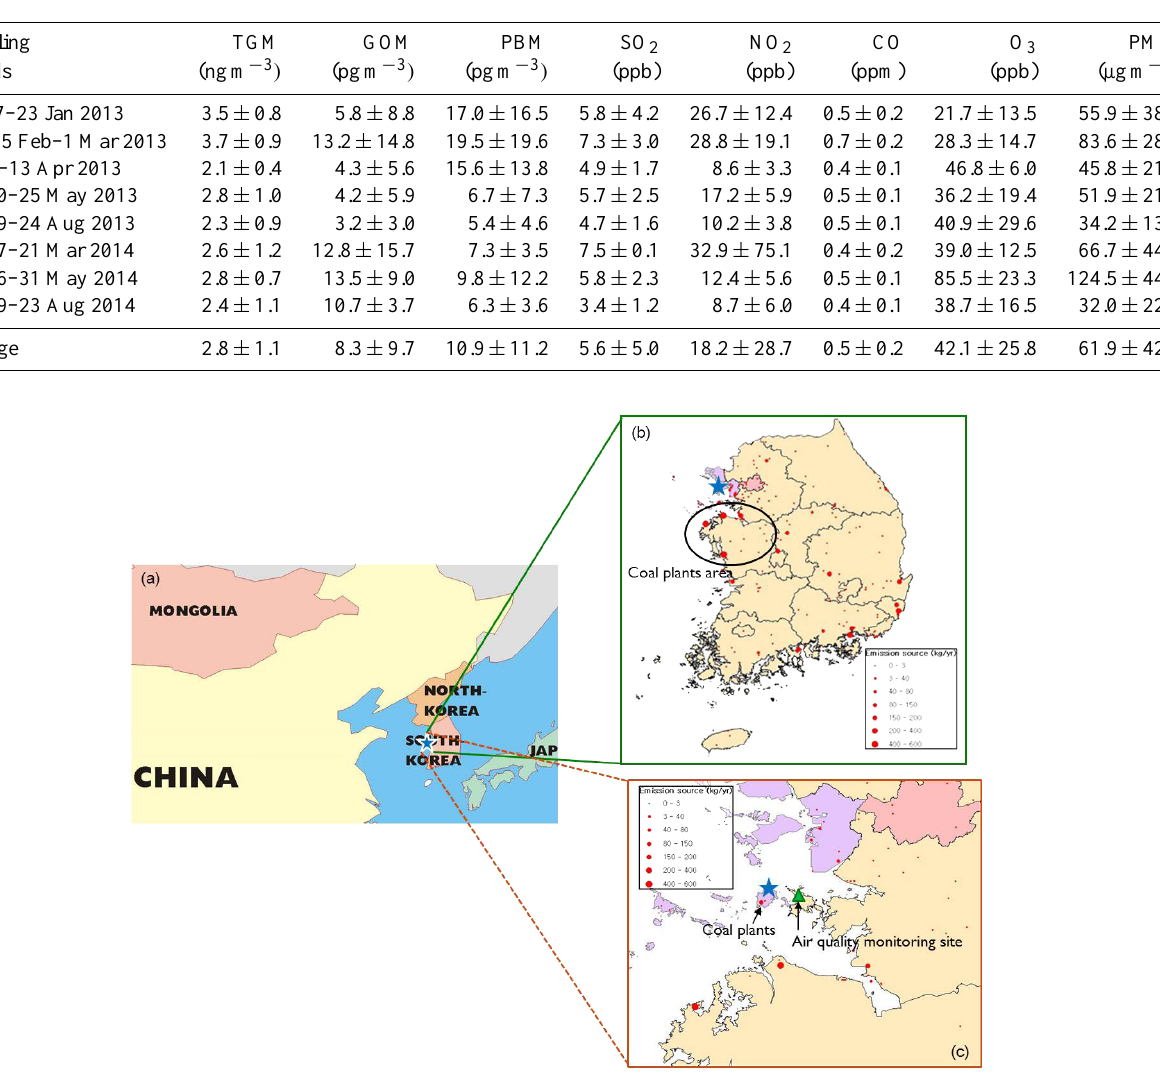
Table 1. Summarized concentrations of speciated Hg and other typical pollutants for each sampling period.